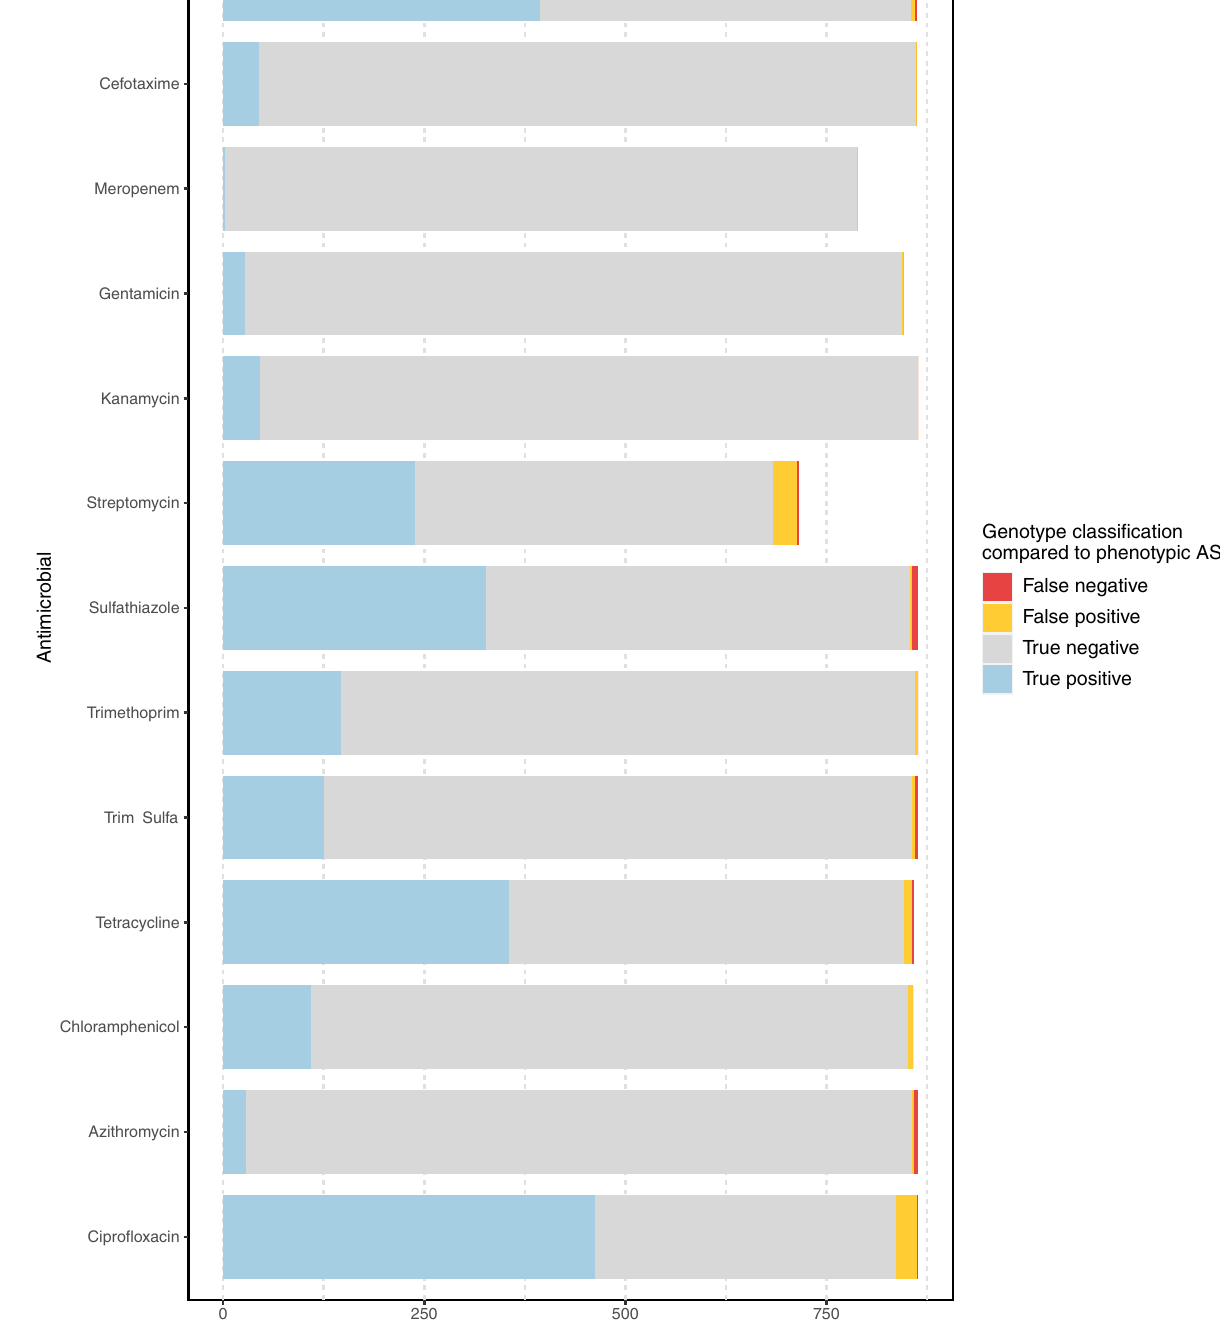
negative, no AMR mechanisms detected in phenotypically resistant isolate. For cipro fl oxacin, ‘ truepositive ’ de fi nedasconcordantintermediateorresistantresults (phenotype and genotype). Abbreviations: AST, antimicrobial susceptibility test- ing; AMR, antimicrobial resistance; Trim-sulfa, trimethoprim-sulfamethoxazole. Source data are provided as a Source Data fi